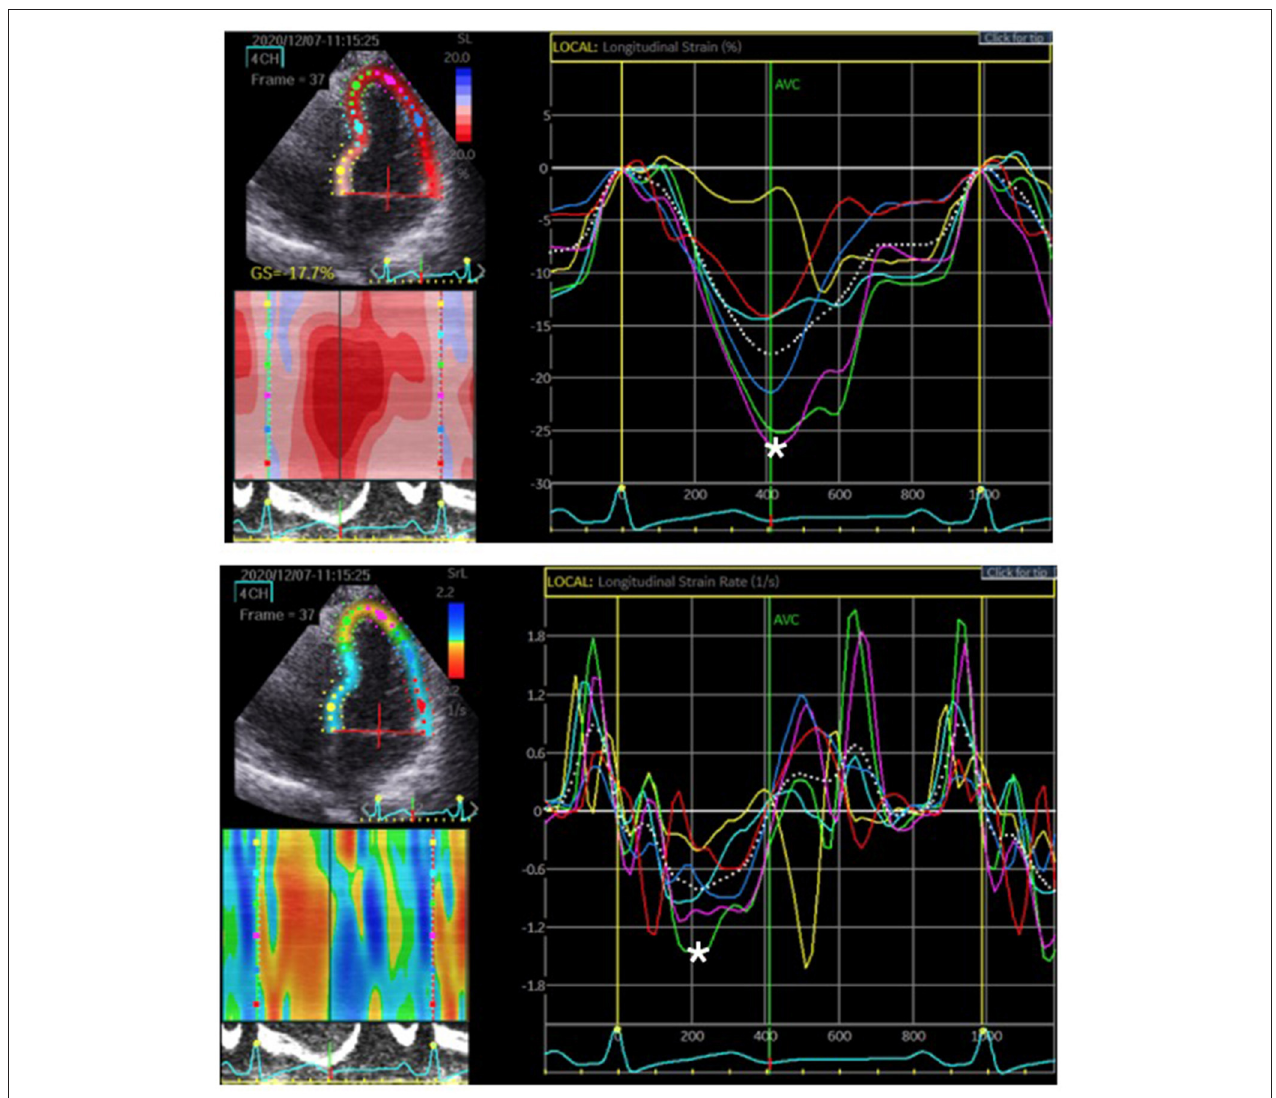
FIGURE 2 | The region of interest, LV myocardium, was tracked. The longitudinal strain and SR were quantified as the peak systolic value in each myocardial segment. The upper figure represents the peak systolic strain. The most negative value, which is denoted by the white asterisk, was measured before aortic valve closure (AVC). The lower figure represents the peak systolic SR. The most negative value is denoted by the white asterisk on the rate/time curve during